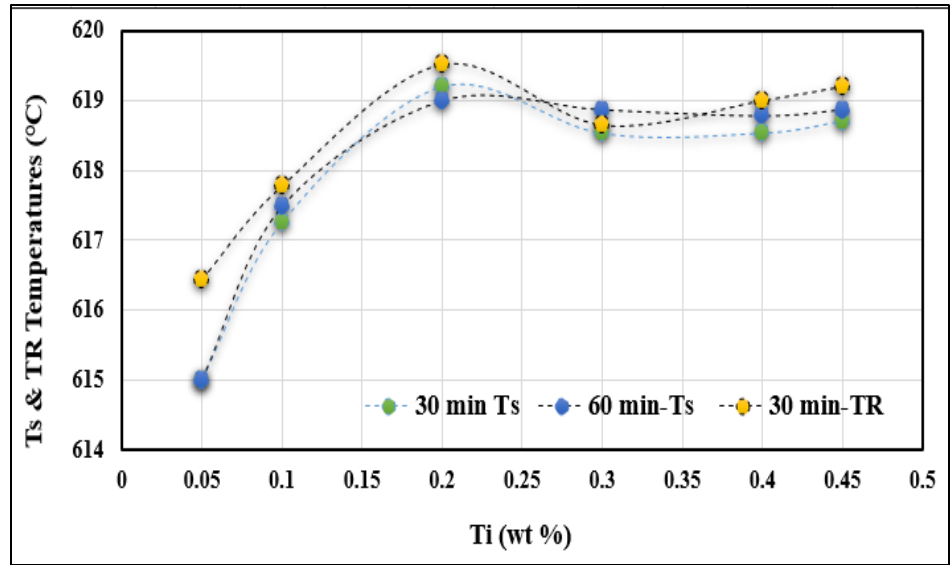
Figure 7. Variation in T S and T R as a function of added Ti; samples were poured from 750 °C after 30- and 60-min holding times.